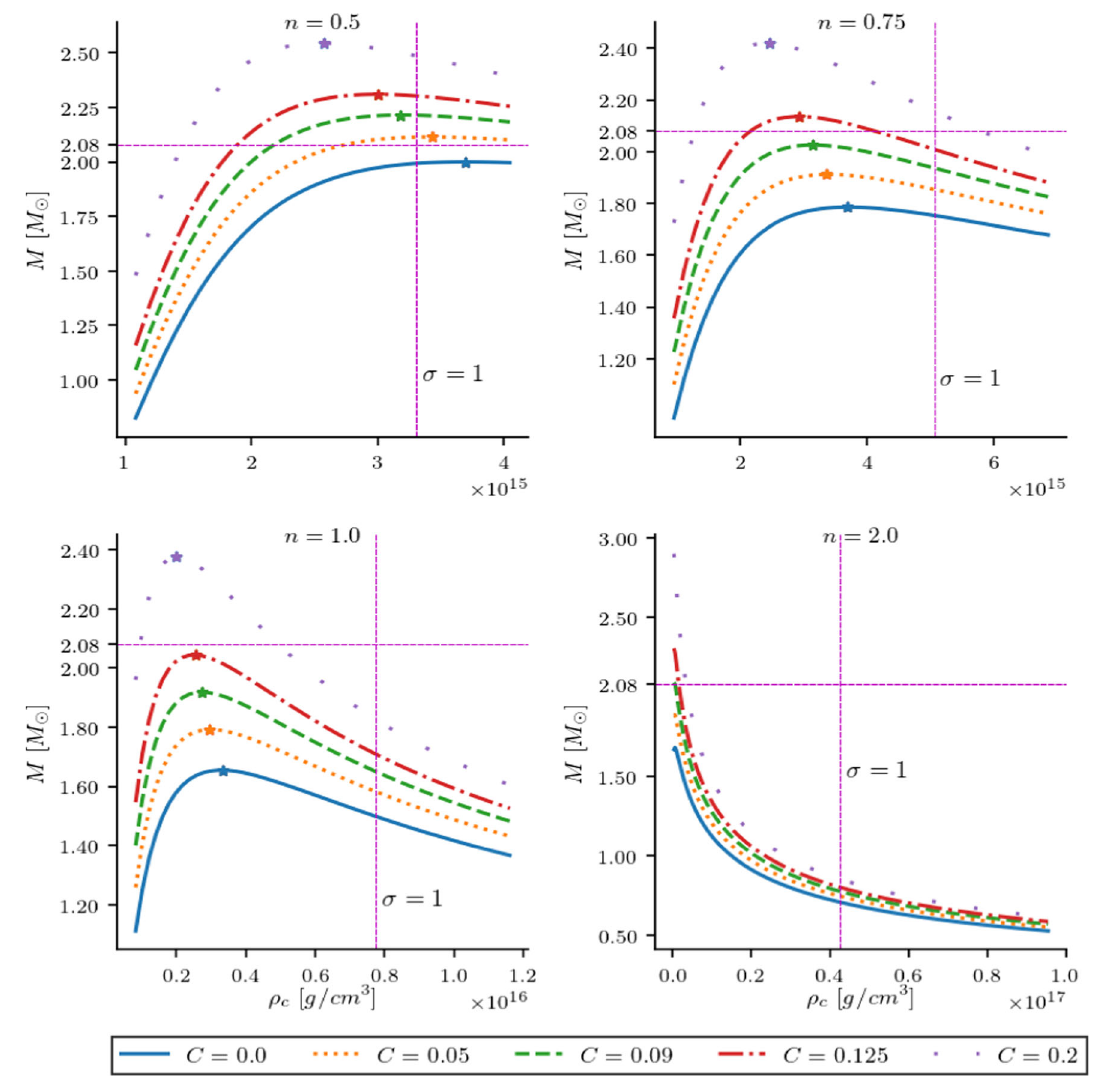
Fig. 5 The total mass, M , as a function of ρ c for models with param- eters α = − 0 . 01, (cid:18) = 0 . 17, and varying C (the anisotropic factor) for several values of the polytropic index n . From the graphics, we can see that the shape of the curves are highly related to the polytropic index n , and they are susceptible to C . The smaller the polytropic index n is, the greater the range of densities that fulfil C7. A star-shaped